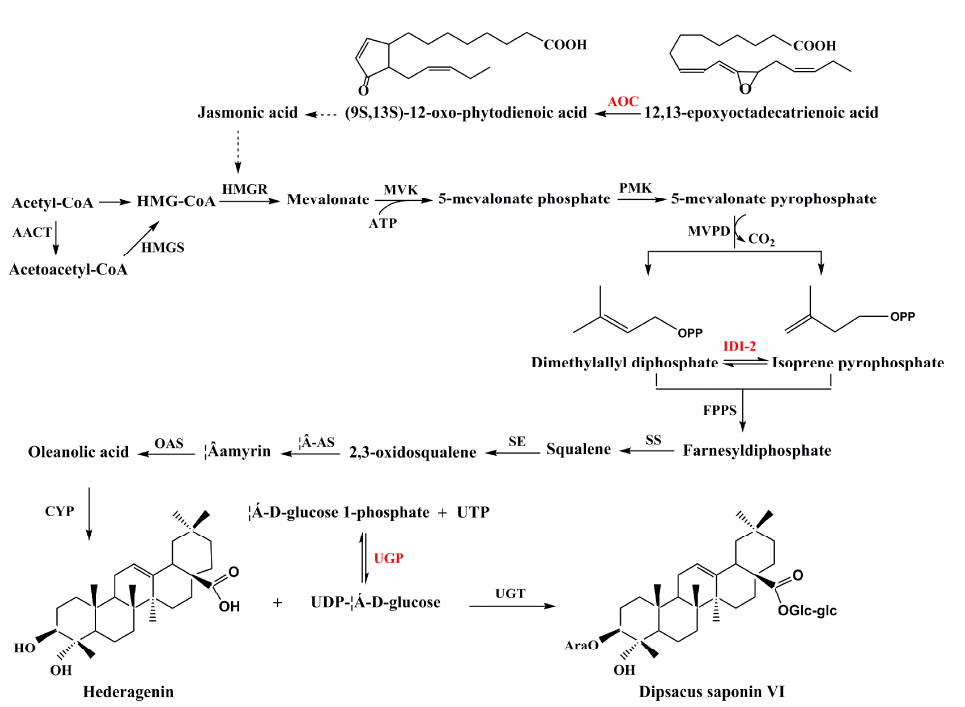
Figure 7. Putative dipsacus saponin VI biosynthesis pathway in cell. The enzymes found in this study are shown in red font. AACT, acetoacetyl-CoA thiolase; HMGS: HMG-CoA synthetase; HMGR, HMG-CoA reductase; MVK, mevalonate kinase; PMK, phosphomevalonate kinase; MVPD,